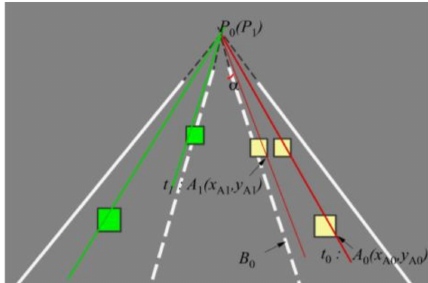
Figure 11. Schematic diagram of the lane change-detecting algorithm for the preceding vehicles.